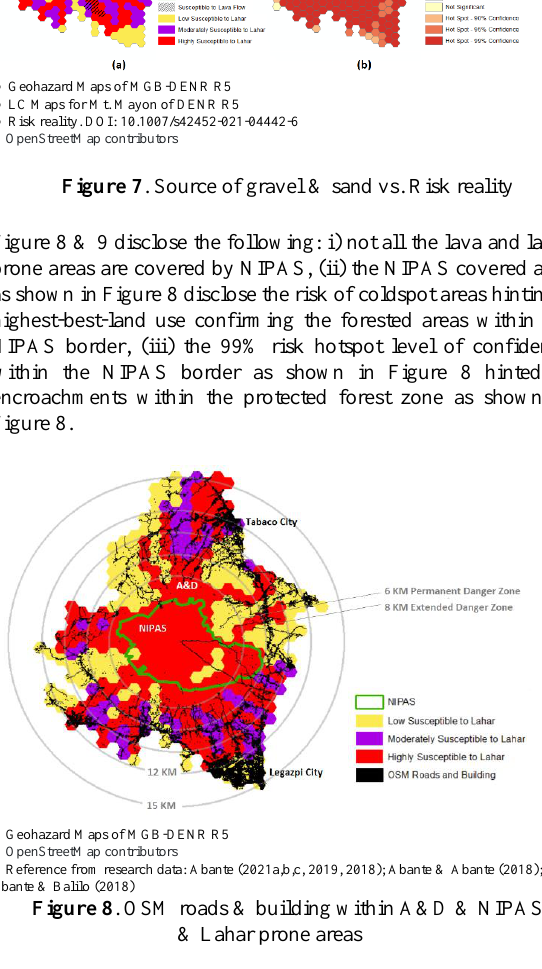
Figure 8 . OSM roads & building within A&D & NIPAS & Lahar prone